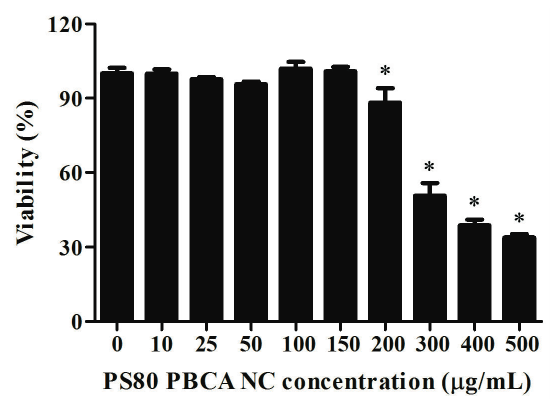
Figure 6. Cytotoxicity of iPSCs to PS80 PBCA NC. Significant cytotoxicity was detected with a PS80 PBCA NC concentration at 200 μ g/mL and beyond. n = 6; * p < 0.001.